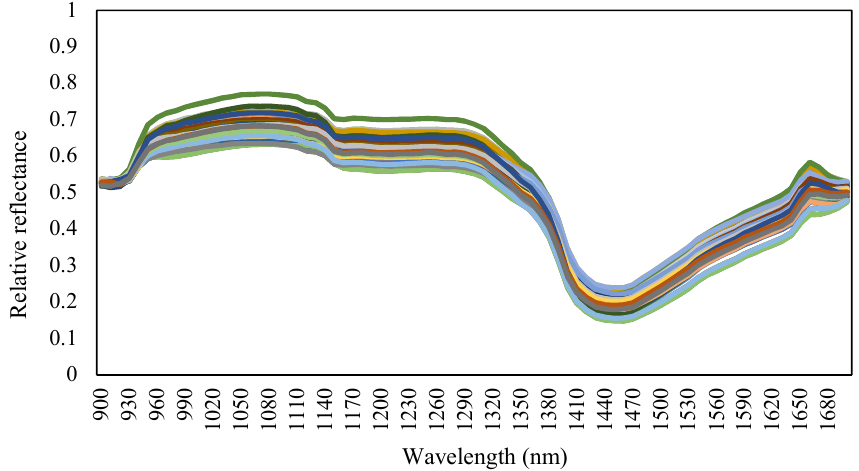
Figure 4. Relative reflectance of the tomato leaf samples.